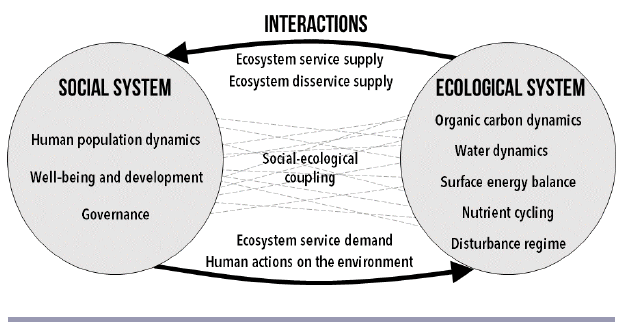
Fig. 2 . Conceptual framework to guide the characterization and monitoring of social-ecological systems (SESs). The